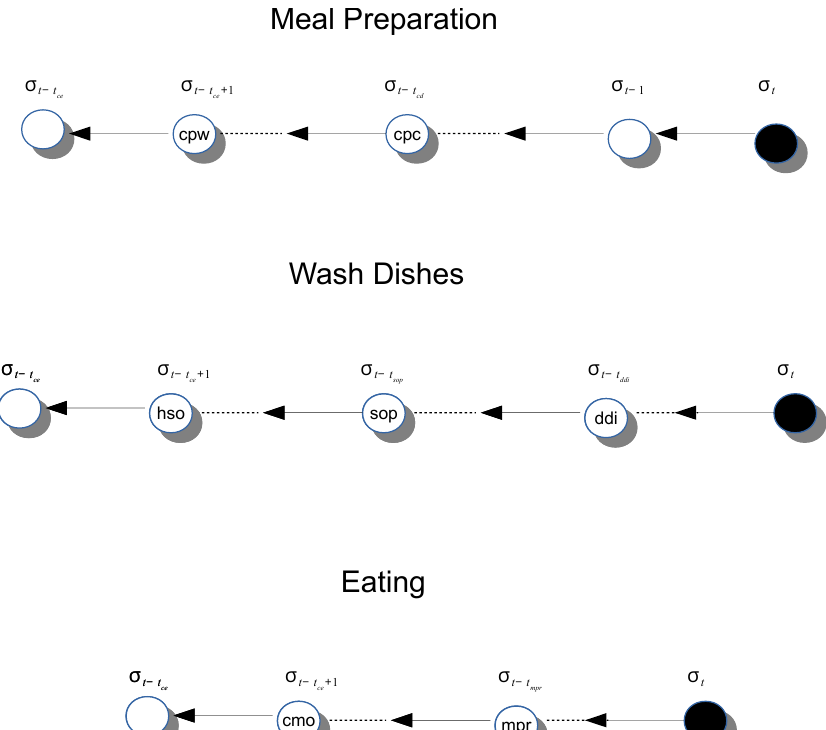
Figure 4. Model formalism used in [38] based on R-pTL formulas. The model is based on correlations between